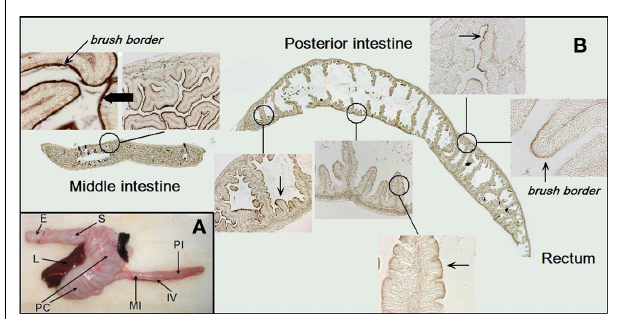
FIGURE 1 | (A) An overview of the morphology of the gastrointestinal tract in Atlantic salmon. (B) A longitudinal section of the entire middle and posterior intestine from SW-acclimated salmon with higher magnifications shown as inserts.The brush border is visualized by staining for alkaline phosphatase activity with NBT/BCIP. Staining of the brush border (dark brown) is seen throughout the intestine, however, more intensely in the middle segment. Abbreviations: E, esophagus; L, liver; S, stomach; PC, pyloric caeca; MI, middle intestine; PI, posterior intestine; IV, ileo-rectal